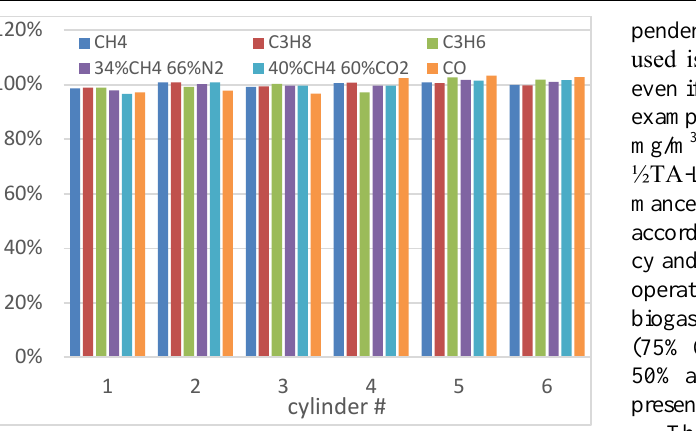
Fig. 5. Individual cylinders balancing comparison for various fuels and HE-MUZG system (balancing referred to average)